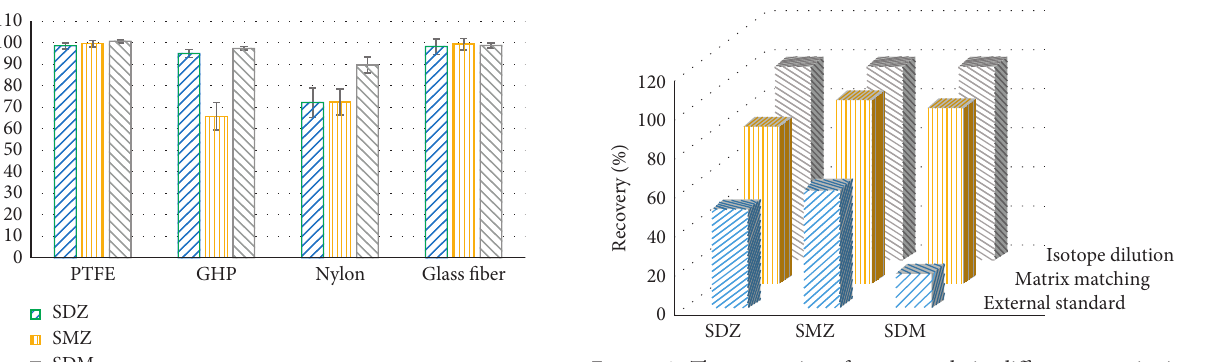
Figure 2: The recoveries of compounds in different quantitative modes with gradient elution. Figure 1: Absolute recoveries of filter after filtration of standard